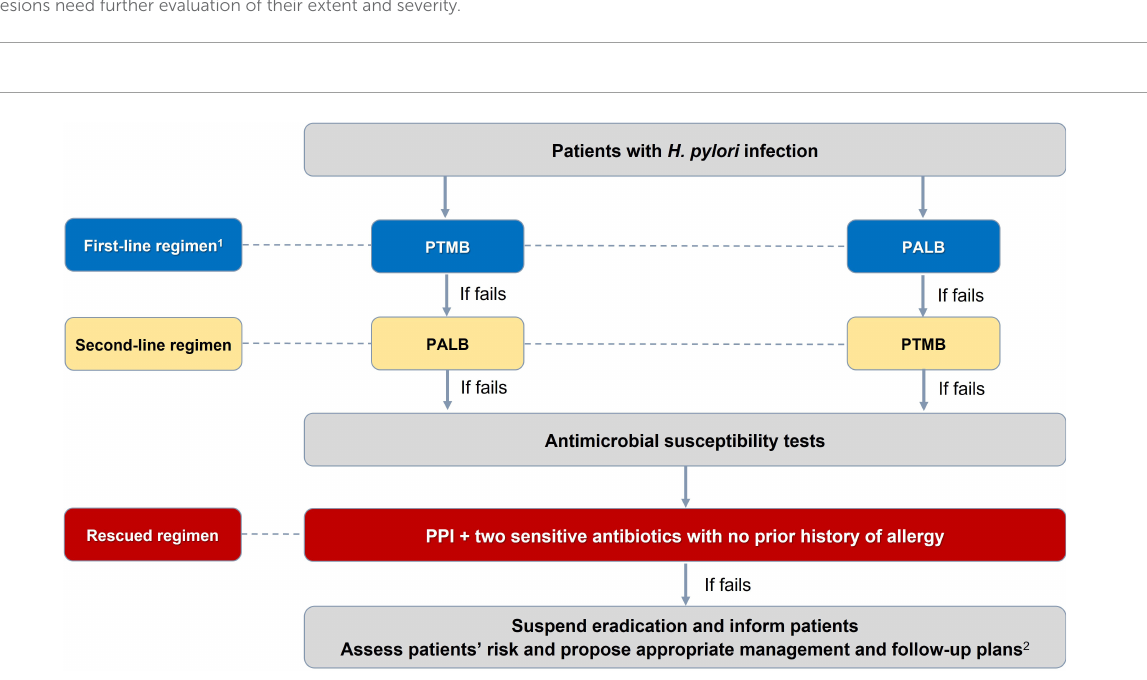
FIGURE1 Algorithm for selection of Helicobacter pylori diagnostic test. 1 The alarm features are presented in Table 2 . 2 In patients with acute upper gastrointestinal bleeding, rapid urease test and histopathology can be falsely negative, and H. pylori infection should be confirmed after stabilizing gastrointestinal bleeding. 3 Serum antibody test should not be used. 4 Patients must stop taking antibiotics or bismuth for at least 4 weeks and PPIs for at least 2 weeks. 5 Patients diagnosed with gastric ulcers, suspected malignant gastric lesions, or gastric precancerous lesions need further evaluation of their extent and severity.